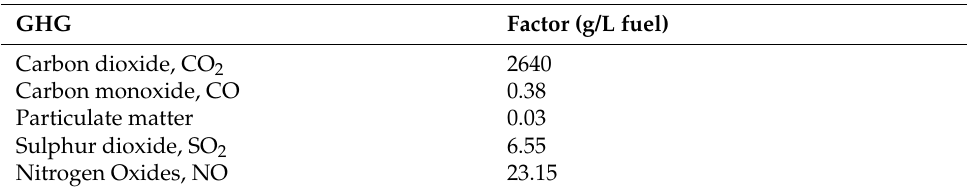
Table 5. Factors utilized for greenhouse gas emission